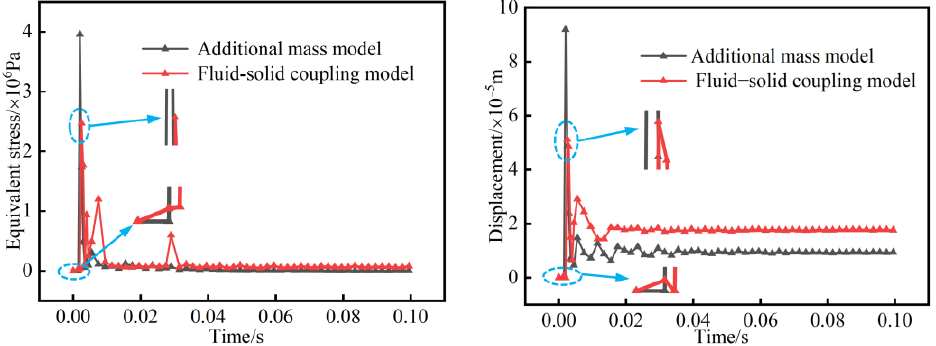
Figure 7. Time – history curves of equivalent stresses ( left ) and X -displacements ( right ). Figure 7. Time–history curves of equivalent stresses ( left ) and X -displacements ( right